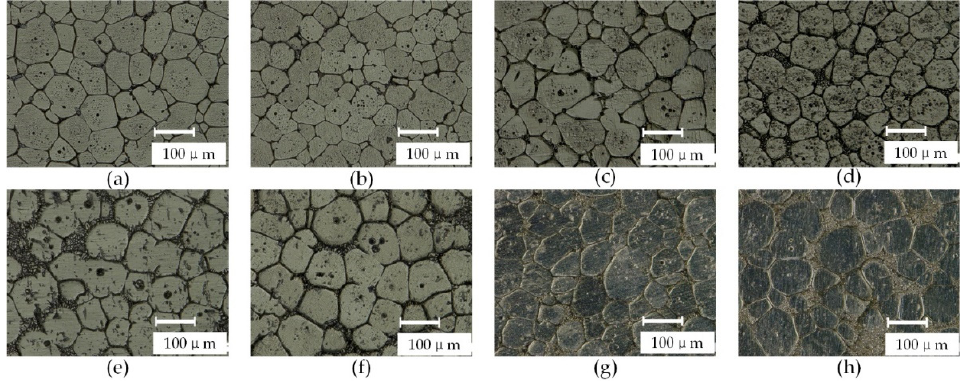
Figure 3. Semi-solid microstructure under isothermal heat treatment for 20 min, ( a ) 610 °C, ( b ) 620 °C, ( c ) 630 °C, ( d ) 640 °C, ( e ) 650 °C, ( f ) 660 °C, ( g ) 670 °C, and ( h ) 680 °C. ( b ) 620 ◦ C, ( c ) 630 ◦ C, ( d ) 640 ◦ C, ( e ) 650 ◦ C, ( f ) 660 ◦ C, ( g ) 670 ◦ C, and ( h ) 680 ◦